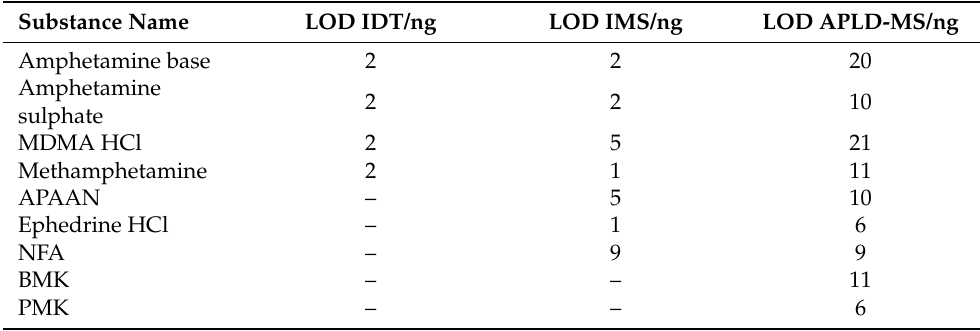
Table 1. Total LOD of all investigated substances for all investigated methods. Two bars mean no LOD